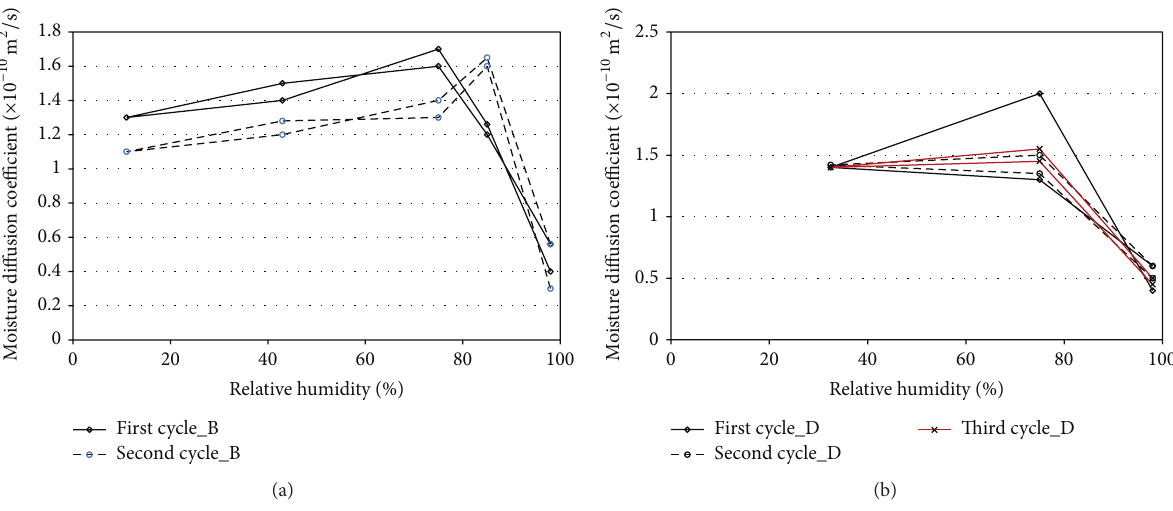
Figure 6: (a) The apparent moisture diffusion coefficient of the sample B1 (b) and the sample D1.